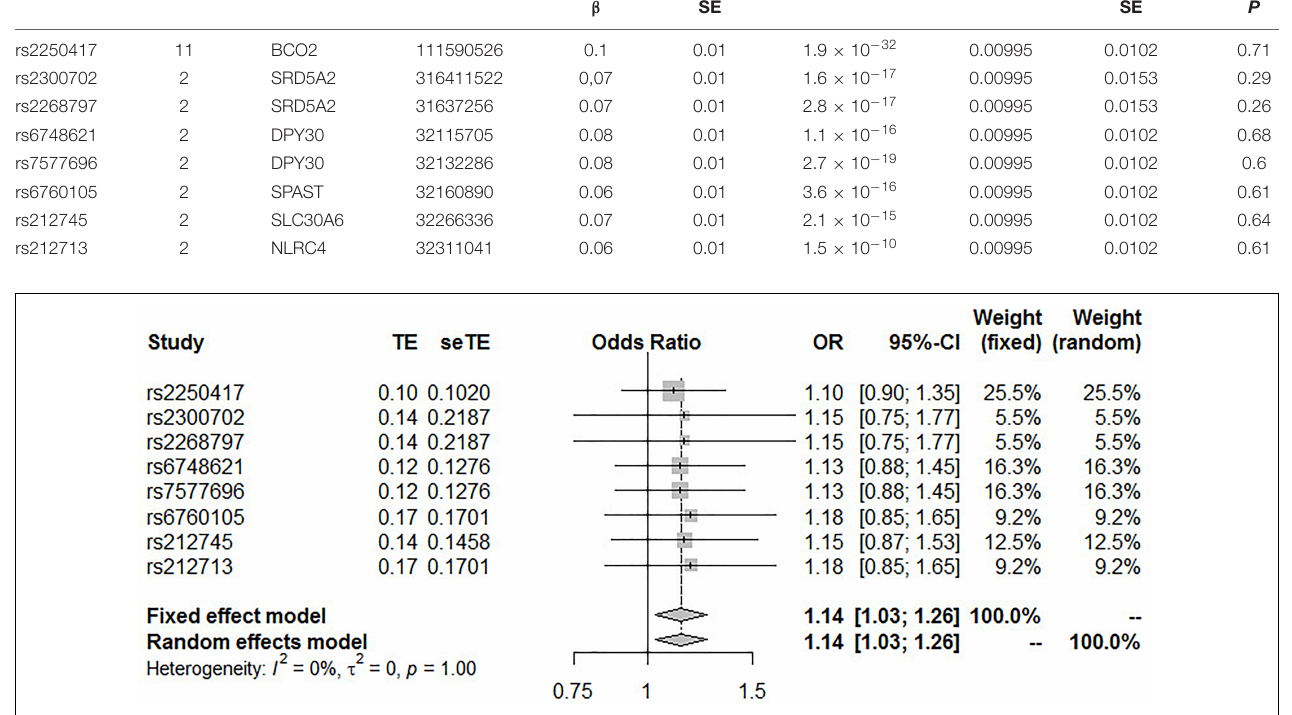
FIGURE 3 | Forest plot revealing Wald ratios and 95% CIs from IL-18-associated